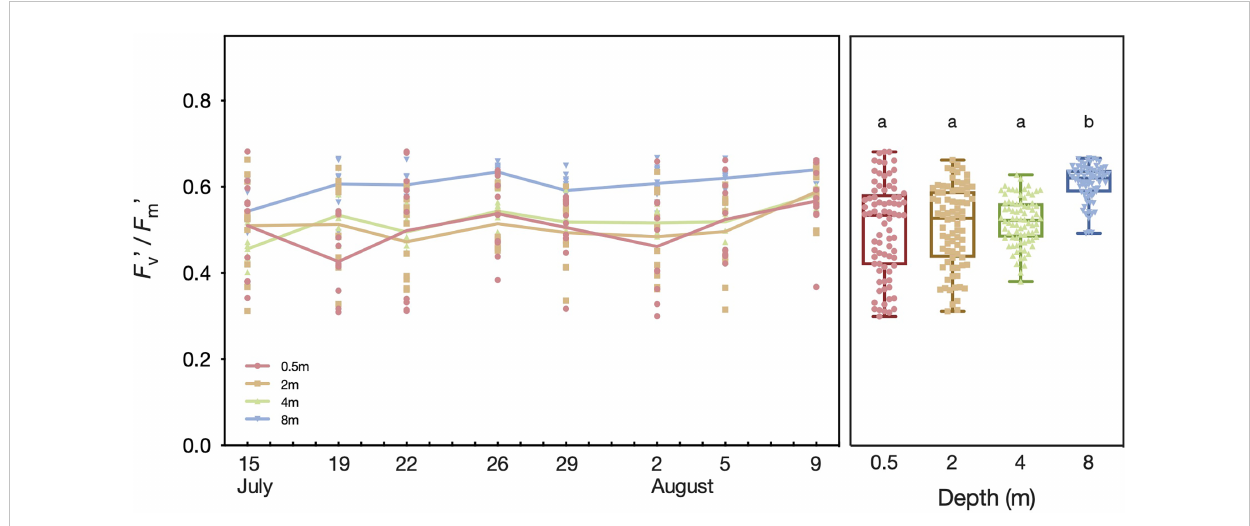
FIGURE 5 Effective quantum yield ( F v ’ / F m ’ ) of Pocillopora verrucosa colonies in different depths at Al Fahal reef in the central Red Sea between 15 th July – 09 th August 2018 on individual days (left panel) and combined for all days (right panel). The colored lines connect mean F v ’ / F m ’ values. Letters above the boxplots show the results of the Tukey ’ s post hoc test, whereby plots that do not share the same letter had signi fi cantly different means at a level of p <